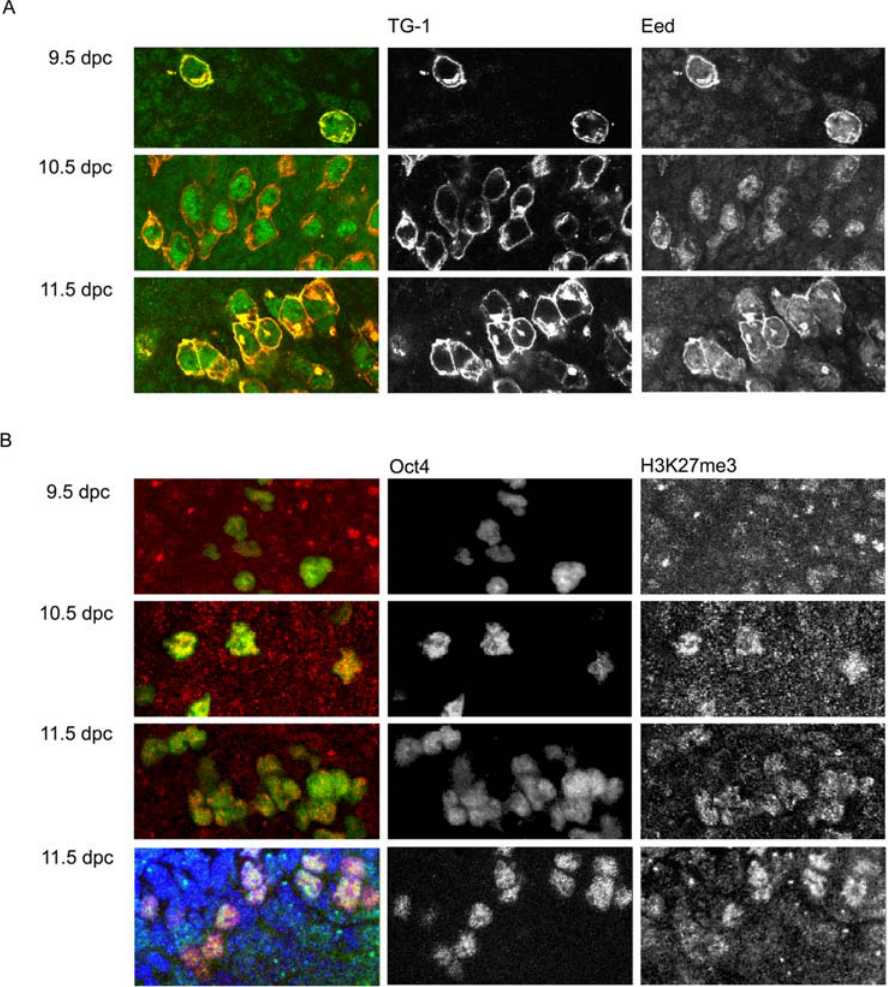
Figure 1. Elevated PRC2 and H3K27me3 levels in developing PGCs. (A) Indirect IF on the hind gut of 9.5 dpc XX embryos and whole genital ridges of 10.5 dpc and 11.5 dpc XX embryos using anti-Eed (in green) and TG-1 (in red/yellow) antibodies. PGCs (TG-1 positive cells) can be easily distinguished from neighbouring cells by their stronger Eed nuclear staining. Both primary antibodies are mouse monoclonals but after sequential detection the signals can be distinguished because TG1 signal is restricted to the cell membrane/cytoplasm and Eed protein is present only in the nucleus. (B) Indirect IF on the hind gut of 9.5 dpc XX embryos and whole genital ridges of 10.5 dpc and 11.5 dpc XX embryos detecting Oct4 (in green) and H3K27me3 (in red). At 9.5 dpc PGCs and neighbouring somatic cells present similar nuclear levels of H3K27me3. At 10.5 dpc and 11.5 dpc, PGCs show much higher levels of this modification than neighbouring somatic cells. The bottom panels show an example where DNA was counterstained with DAPI (blue) to reveal the nuclei of all cells in the section. Images correspond to a single confocal section at 630 6 original magnification.